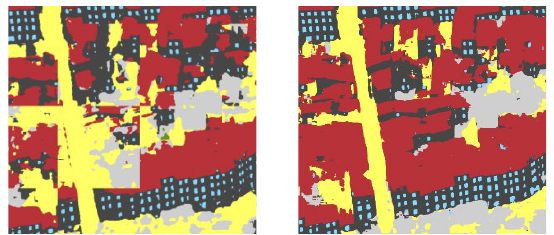
Figure 2 . Bordeaux dataset – oblique aerial images CNN prediction results without (left) and with mosaic mechanism (right).